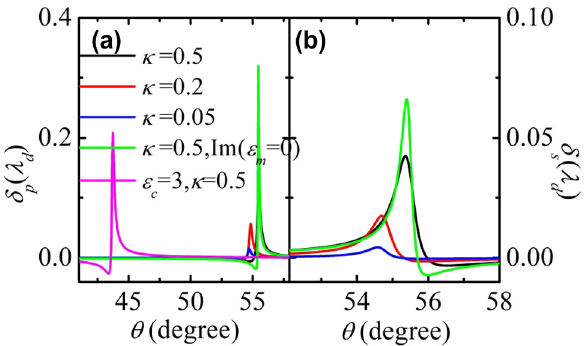
Figure 8: The total Imbert–Fedorov shift of the reflected beams by linearly polarized incident beams for different 𝜅 . Here, 𝜀 = 100 nm, and d = 150 nm. d m c